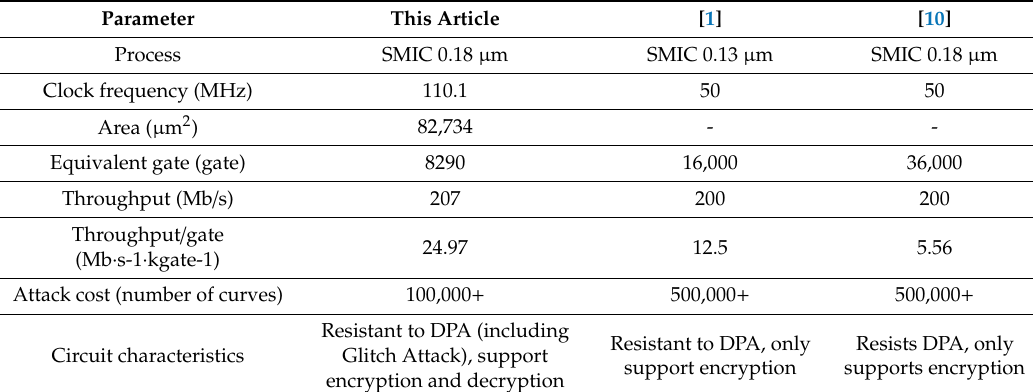
Table 5. Comparison of performance parameters and resource overhead of ASIC